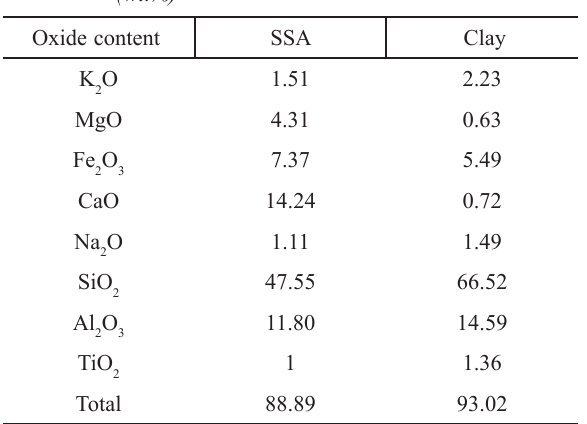
Table 5 – Chemical composition of SSA and clay (oxides) (wt.%) Oxide content